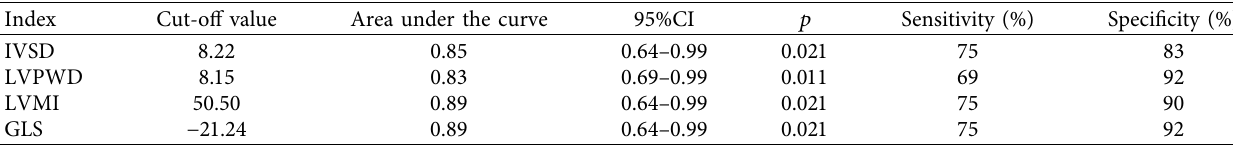
Table 5: ROC curve analysis results of GLS and conventional 2DE-related indicators.